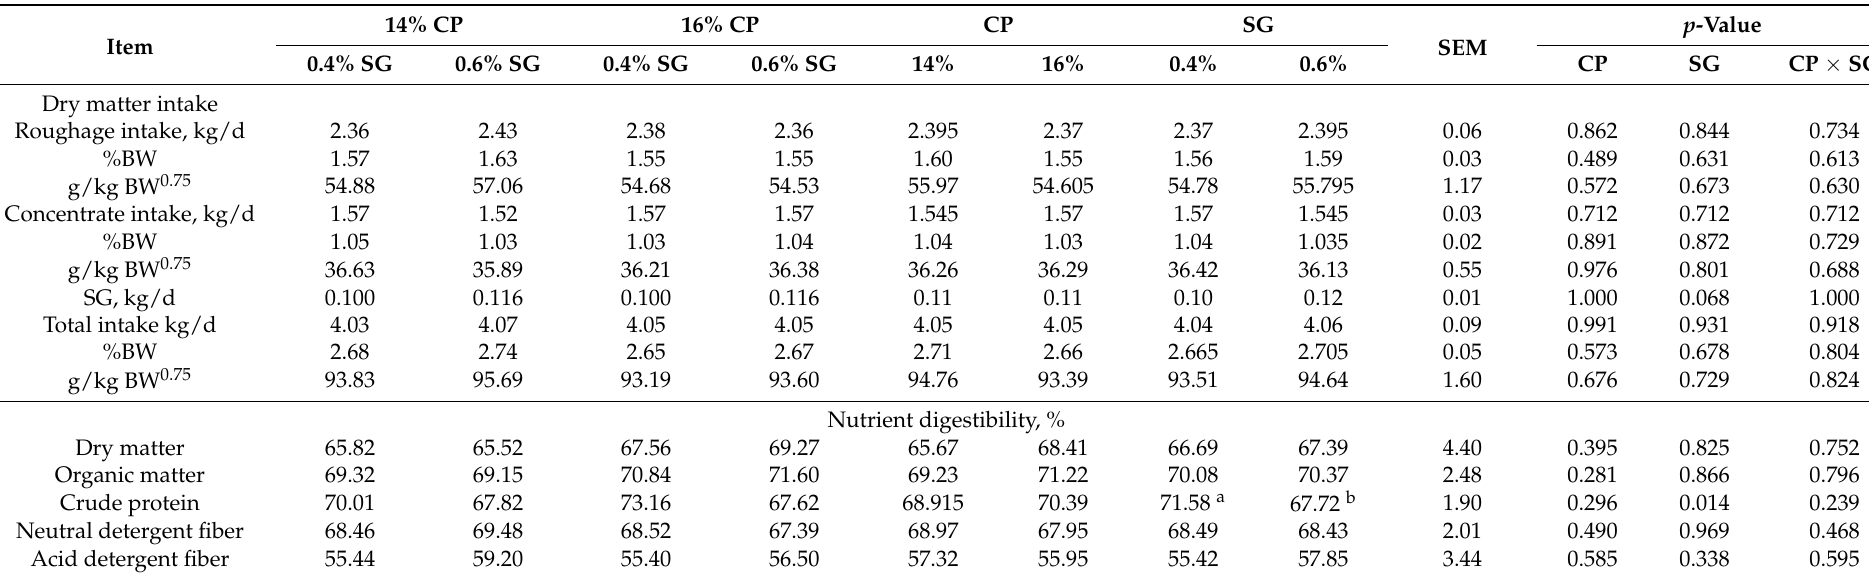
Table 3. Effects of crude protein (CP) levels (14 vs. 16%) in concentrate with S. graniflora pods meal (SG, 0.4% vs. 0.6% dry matter intake) on feed intake and digestibility in Thai native beef cattle.